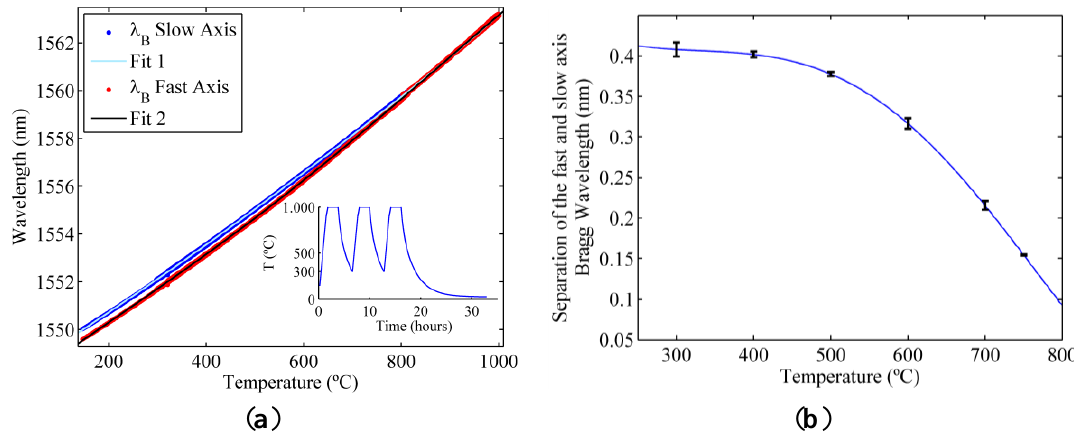
Figure 2. ( a ) Wavelength shift with temperature of the slow and fast axis Bragg resonances; ( b ) Separation between the slow and fast axis Bragg